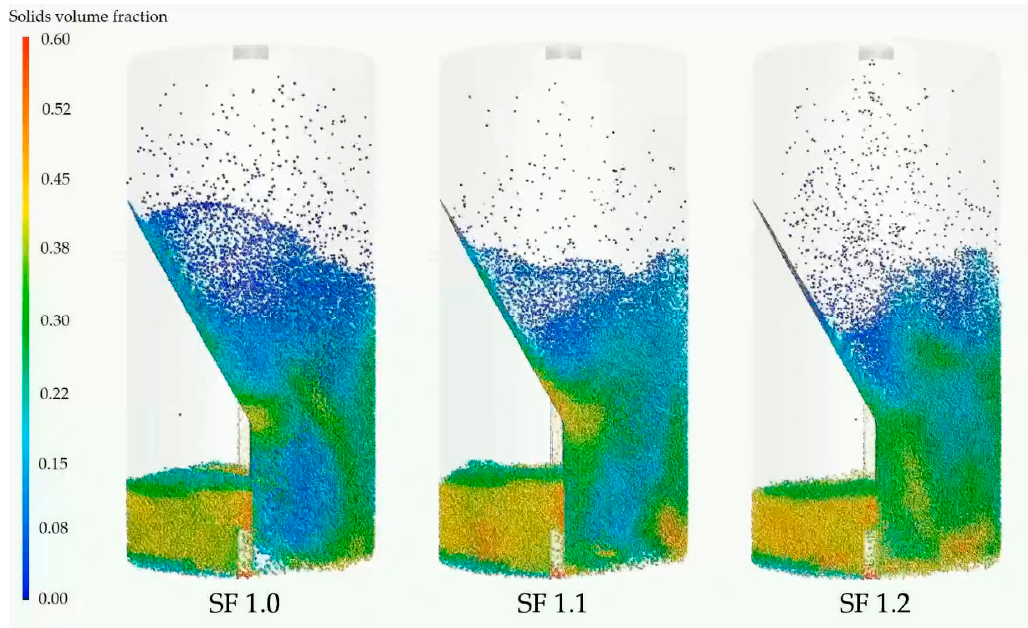
Figure 10. Instantaneous particle plot of the cases with reactor scaling factors ranging from 1 to 1.2, where the particles are colored by the particle volume fraction. A corresponding animation is provided in Video S4. Note that the particles pictured are tracers following the continuous solids flow for visualization purposes and do not influence the simulation solution.